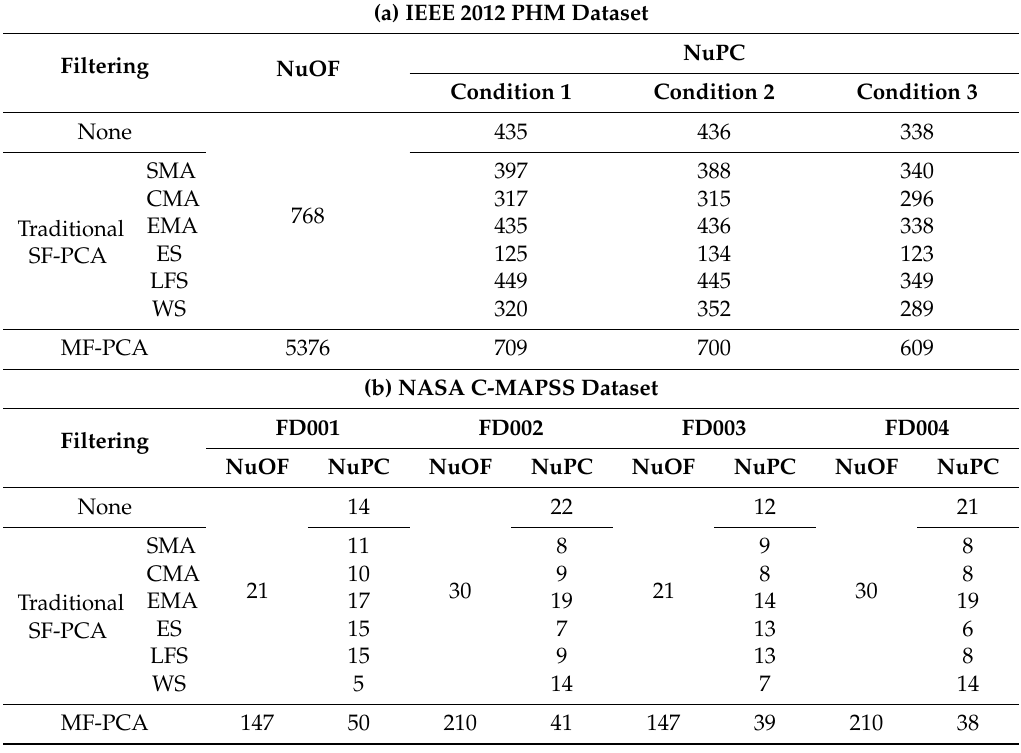
Table 4. The numbers of principal components selected by PCA process in MF-PCA and SF-PCA approaches. The principal components that explain 99% of the data variance were selected. ( a ) IEEE 2012 PHM and ( b ) NASA C-MAPSS datasets. NuOF and NuPC stand for “the number of original features” and “the number of principal components selected”,